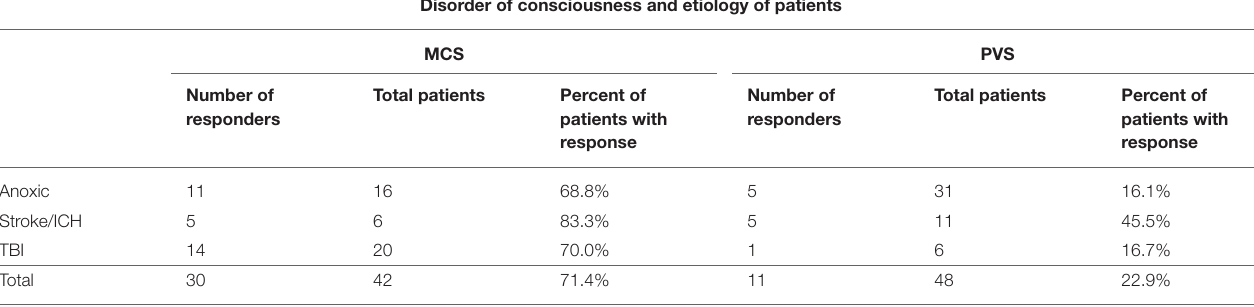
TABLE 3 | Percent of patients with response stratified by disorder of consciousness and etiology.